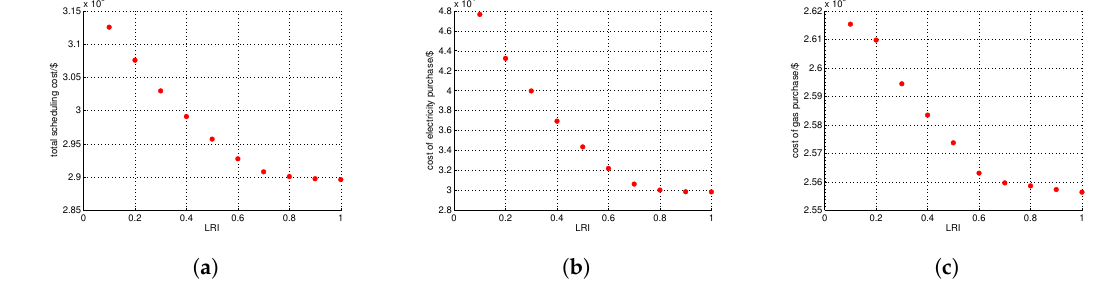
Figure 6. Relation between offline potential-based LRI and optimal scheduling results in Scenario 1. ( a ) The relation between LRI and optimal energy cost. ( b ) The relation between LRI and optimal cost of electricity purchase. ( c ) The relation between LRI and optimal cost of gas purchase.